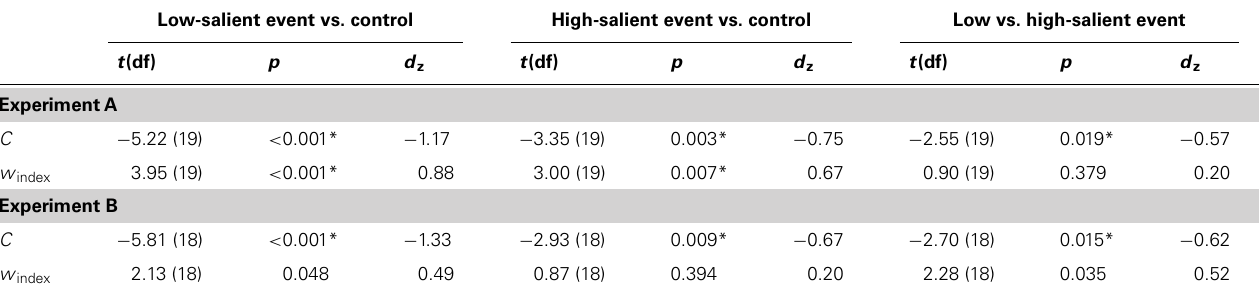
Table 3 | Pairwise comparisons between attentional components of the three conditions. Low-salient event vs. control High-salient event vs. control Low vs. high-salient